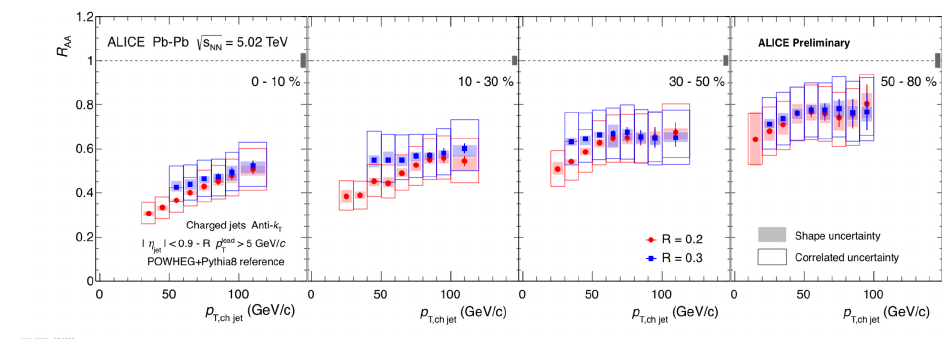
Figure 3. Nuclear modification factors, R AA for charged jets with resolution parameters R = 0 . 2 and R = 0 . 3 in Pb-Pb collisions at √ s NN = 5 . 02 TeV in di ff erent centraility intervals.